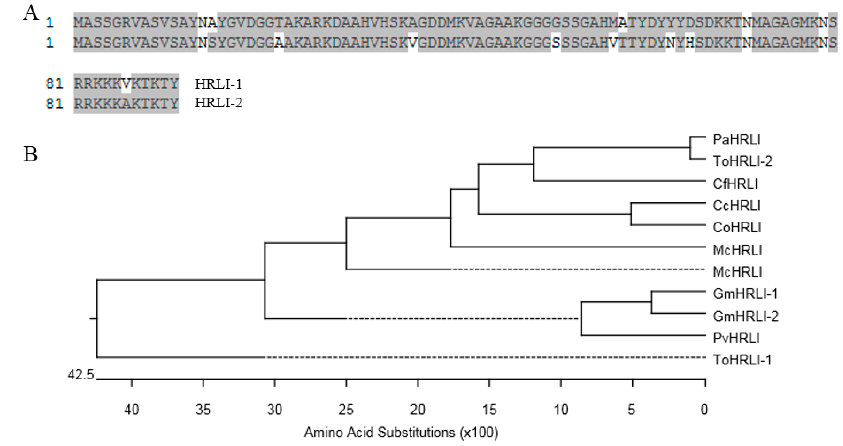
Figure 4. Sequence analysis of HRLI proteins. ( A ) Amino acid sequence alignment of GmHRLI paralog proteins, which were carried out using ClustalW in the Megalign program of the DNASTAR package, with identical residues shaded in gray. Numbers indicate the position of amino acid residues. ( B ) Phylogenetic relationships of HRLI from different species which were carried out using ClustalW in the Megalign program of the DNASTAR package. The abbreviation species are as following: Pv ( Phaseolus vulgaris ), Mc ( Macleaya cordata ), Cf ( Cephalotus follicularis ), To ( Trema orientale ), Pa ( Parasponia andersonii ), Cc ( Corchorus capsularis ), and Co ( Corchorus olitorius ).